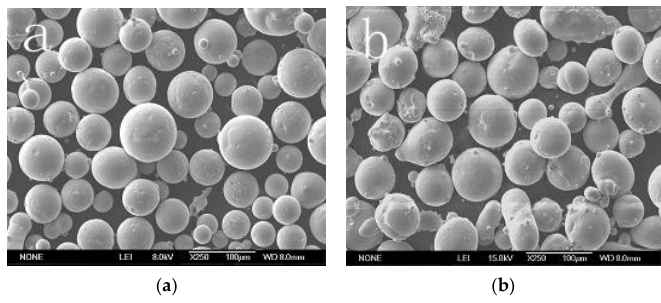
Figure 1. Morphologies of ( a ) the NiCrMoY Powders and ( b ) the Ni60A Powders.